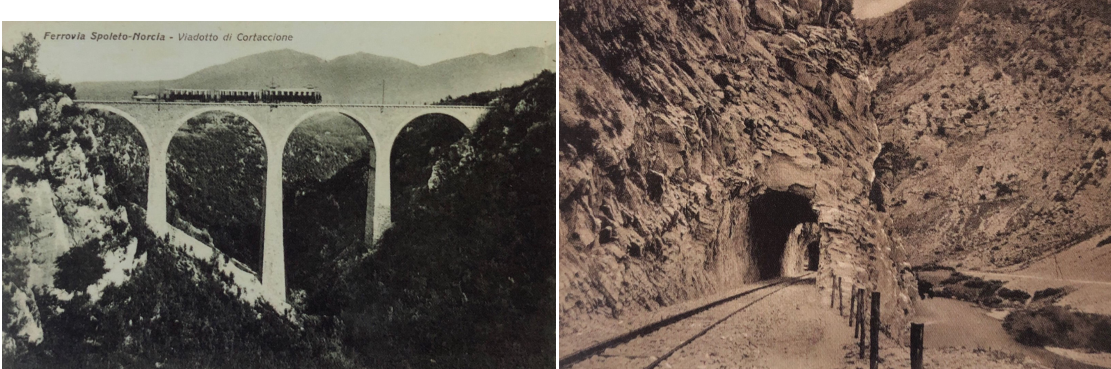
Figure 1. Map of landslide susceptibility with location of study area (black squares).